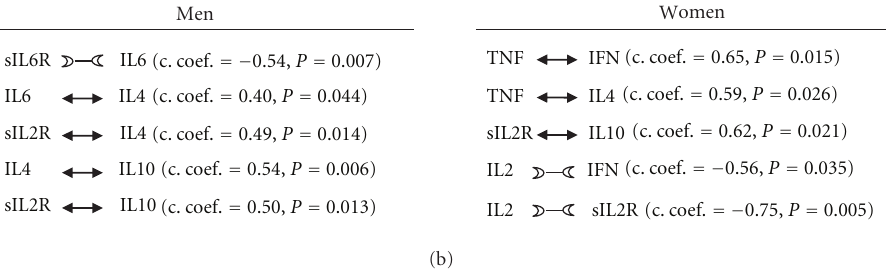
Figure 2: Di ff erences between men and women in the relationships of serum “level network profiles” could represent possible gender biomarkers for sexually dimorphic generation of immune responses in health and disease states. In healthy subjects (a), significant gender- specific and gender-common Th1/Th2 network relationships were found in serum which could be used as biomarkers to identify the direction of T cell di ff erentiation. However, in neither sex did the IL10 cytokine interact with other network components. In colorectal cancer patients (b) no significant relationships with IFN γ in the male group were observed or with IL6 in the female group, indicating alterations in the gender-specific Th-cytokine pathways; significant relationships between IL10 and other Th1/Th2 network components were observed in both men and women groups indicating alterations in the gender-common pathways but through di ff erent Th1/Th2